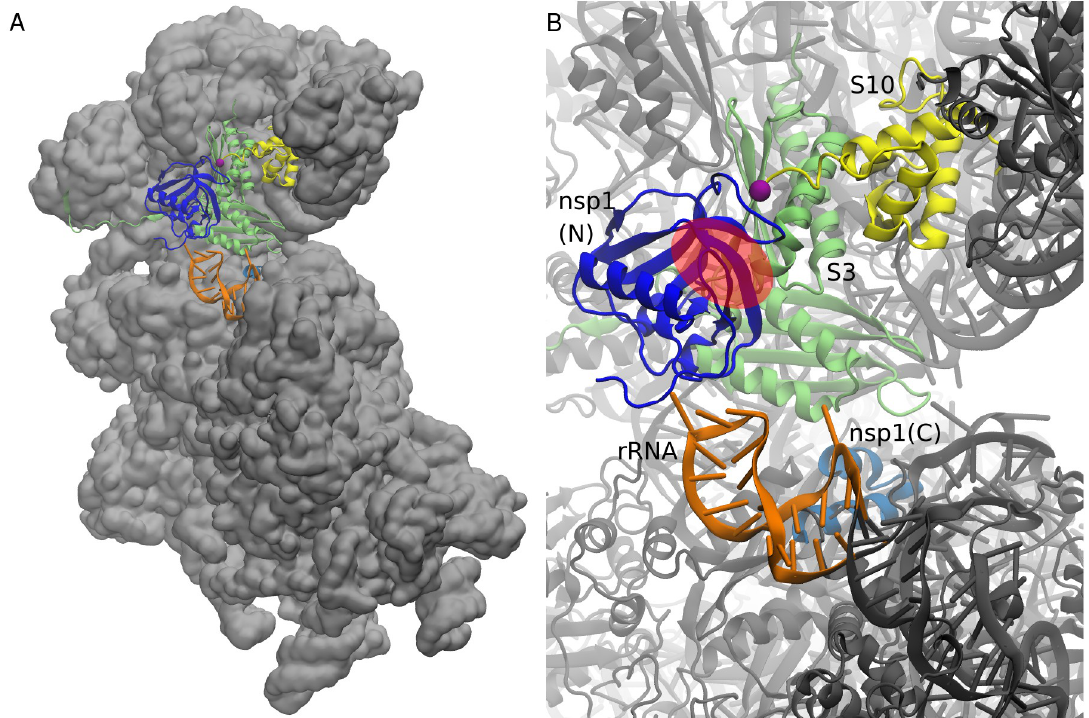
Fig 8. Mapping of the binding surface over the nsp1–40 S ribosome complex. (A) Overview of the nsp1–40 S ribosome complex structure modeled from cryo-EM structure and its electron density map combined with the cross-linking mass spectrometry. (B) Close- up view of the structures around nsp1. The N-terminal and C-terminal parts of nsp1 are colored blue and cyan. A hairpin of rRNA (residue number 531 to 550) is colored orange, and the ribosomal proteins S3 and S10 are colored yellow and lime green, respectively. C- terminal region of S10 after residue 97 (purple sphere) is considered to be the disordered region and is not visible in the structure. Region corresponding to the “valley” of nsp1 binding surface is presented as a red transparent